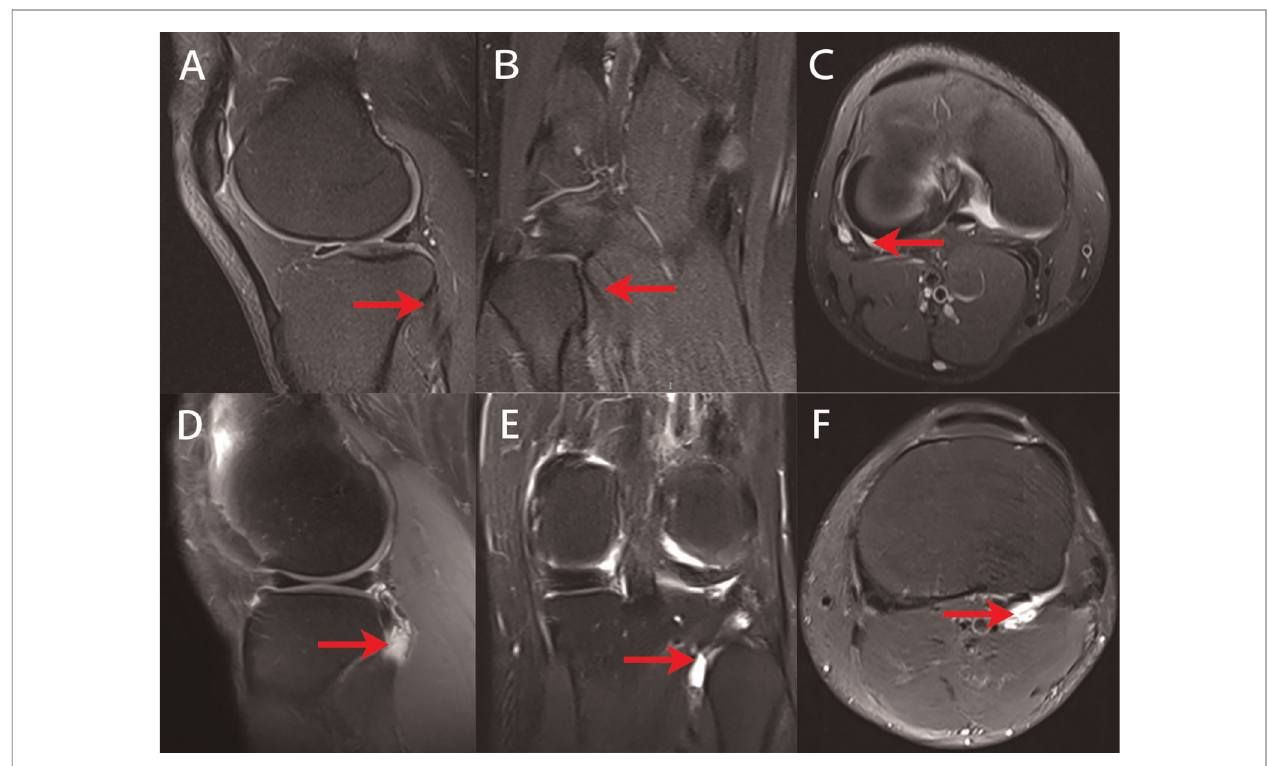
FIGURE 1 | MRI images of the knees of normal people and of patients with popliteus tendinitis. Red arrows show the location of the popliteus tendon. ( A – C ) Preoperative sagittal, coronal and horizontal MRI views of MRI of the normal people. ( D – F ) Preoperative sagittal, coronal and horizontal MRI views of a 55-year- old female with popliteus